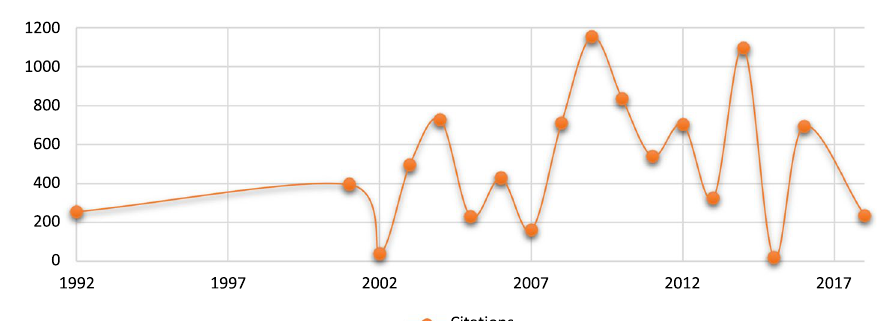
Fig. 1 Citations of top 10 research documents according to search